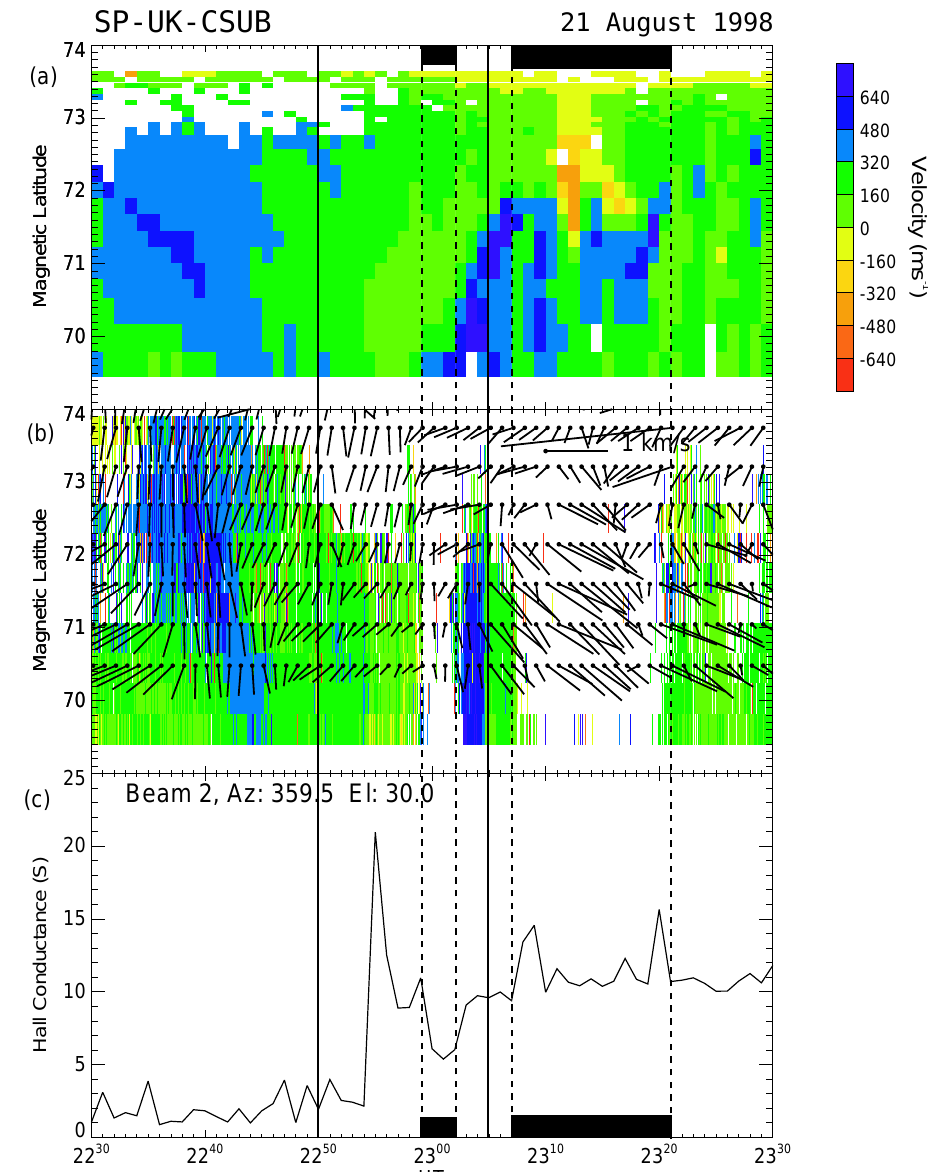
Fig. 10. (a) Line-of-sight velocity measurements from the ESR, as a function of magnetic latitude, for the interval 22:30–23:30UT. Pi2 onset times are marked with vertical solid lines and the intervals of HF radar data loss with vertical dashed lines, as in Fig. 2. (b) Hankasalmi beam 9 measurements of line-of-sight velocity for the same times and latitudes as panel (a). Overlayed are estimates of the convection velocity, derived from a beam-swinging analysis of data from beams 1 and 2 of the EISCAT VHF system. (c) An estimate of the Hall conductance derived from data measured in the beam 2 direction of the EISCAT VHF